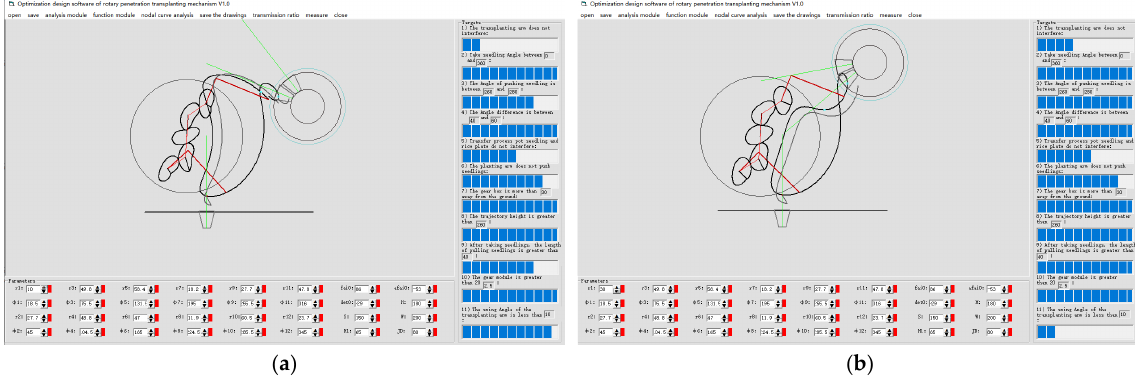
Figure 5. ( a ) transplanting trajectory with decreasing center distance; ( b ) transplanting trajectory with increasing center distance.